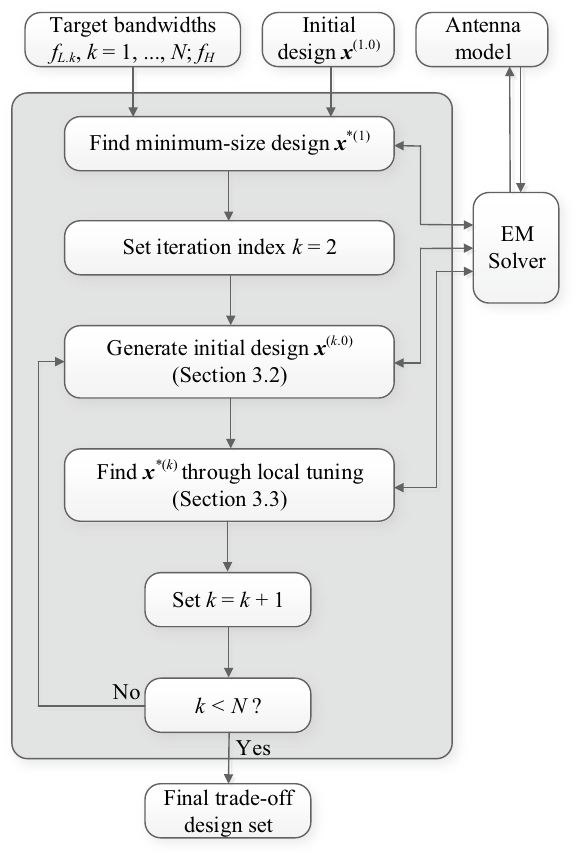
Figure 3. Flow diagram of the proposed procedure for generating the family of minimum-size circularly- polarized antenna design as a function of the operating band.